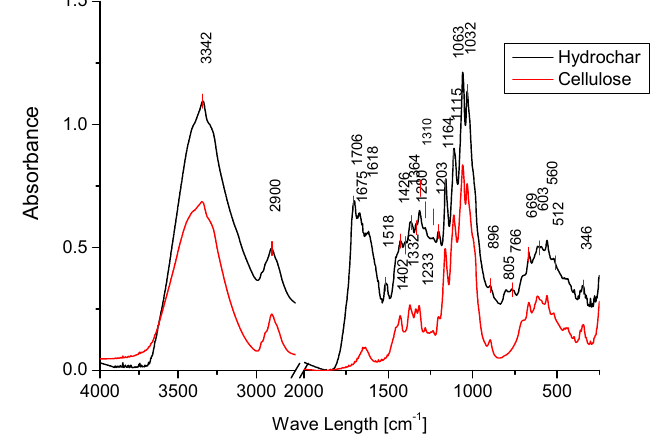
Figure 10. IR spectra of lignin and its hydrochar (10% DM, 220 °C, 4 h). (Modified from [21]).